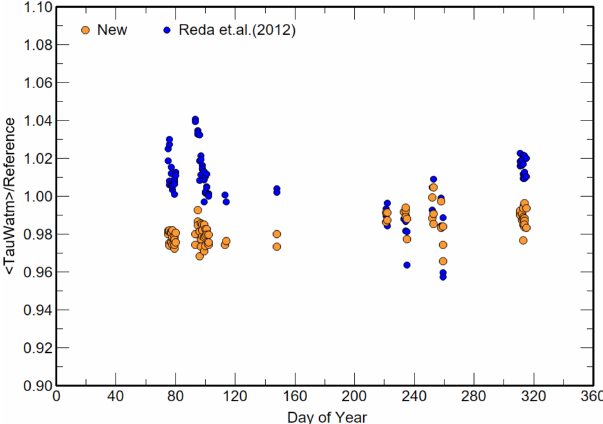
Figure 8. Concentrator transmission estimates derived from divid- ing the linear LSQ-obtained <τW atm > by W IRIS4 for 63 estimates using the new Eq. (18) and the Reda et al. (2012) Eq. (22) estimate of <τW atm >